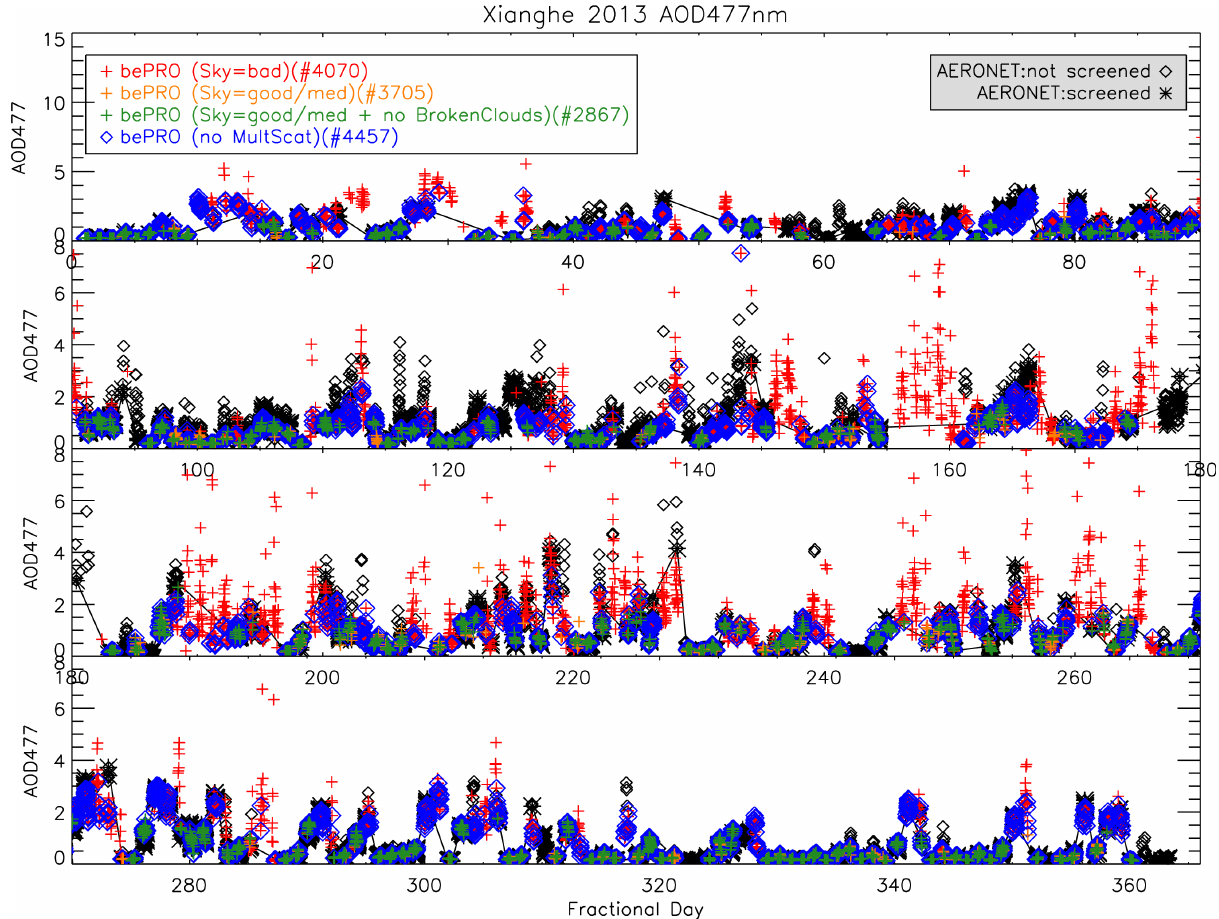
Figure 12. Example results of our bePRO AOD retrievals (crosses) compared to co-located AOD measurements (black diamonds/asterisks for non-screened/screened respectively). The different colours used for the retrievals denote the different cloud-screening results. Data with a “bad” sky flag are in red, data with a “good” or “mediocre” sky flag are in orange, data with a “good” or “mediocre” sky flag plus no broken-cloud flag are in green, and data with no multiple-scattering flag are in blue. More results can be found in the online supplementary